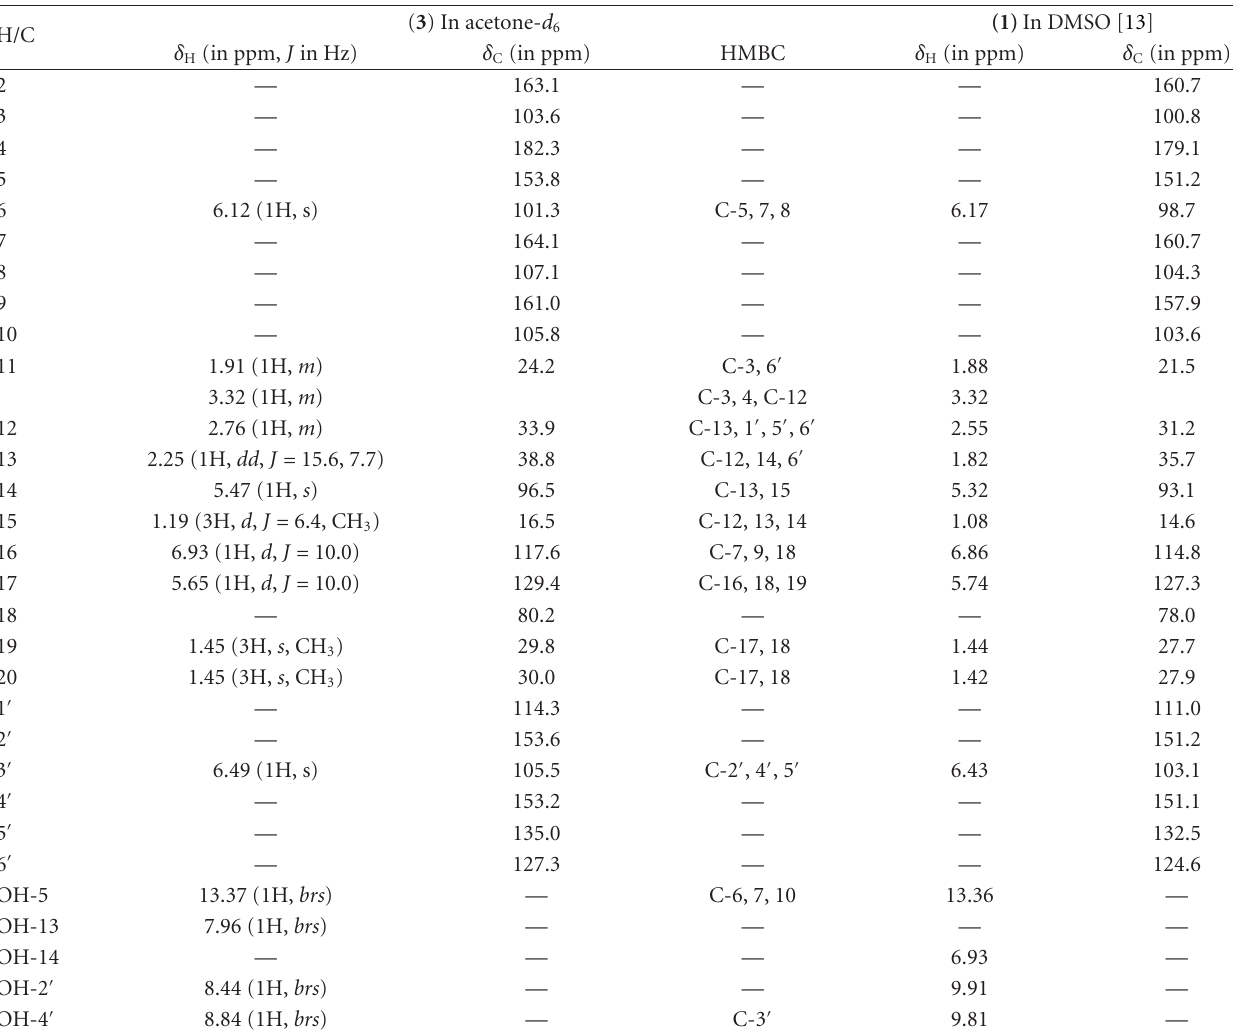
Table 1: 1 H-NMR (400MHz) and 13 C-NMR (100 MHz) spectral data of pyranocycloartobiloxanthone B (3) and pyranocycloartobiloxan- thone A